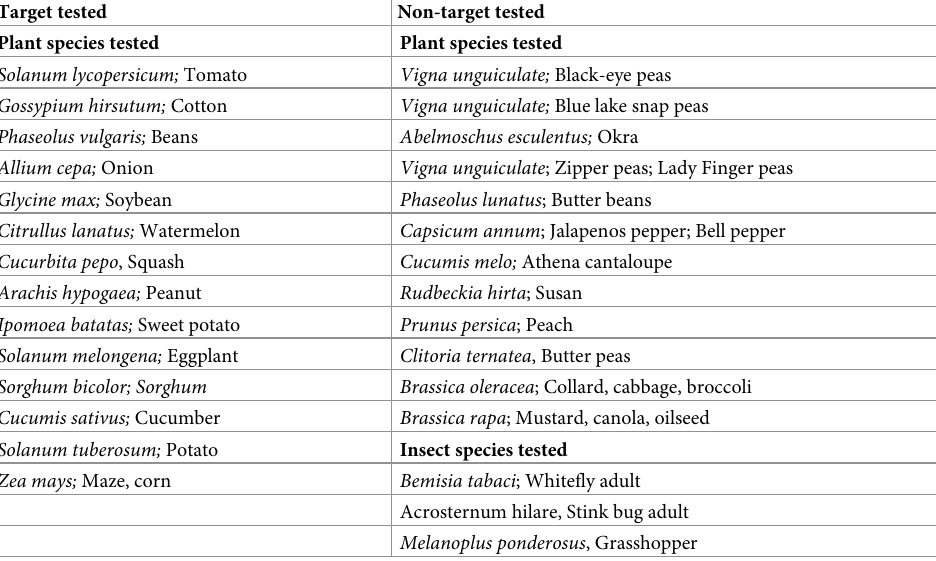
Table 3. List of target and non-target plant and insect species used to test for individual primer specificity evalua- tions using singleplex